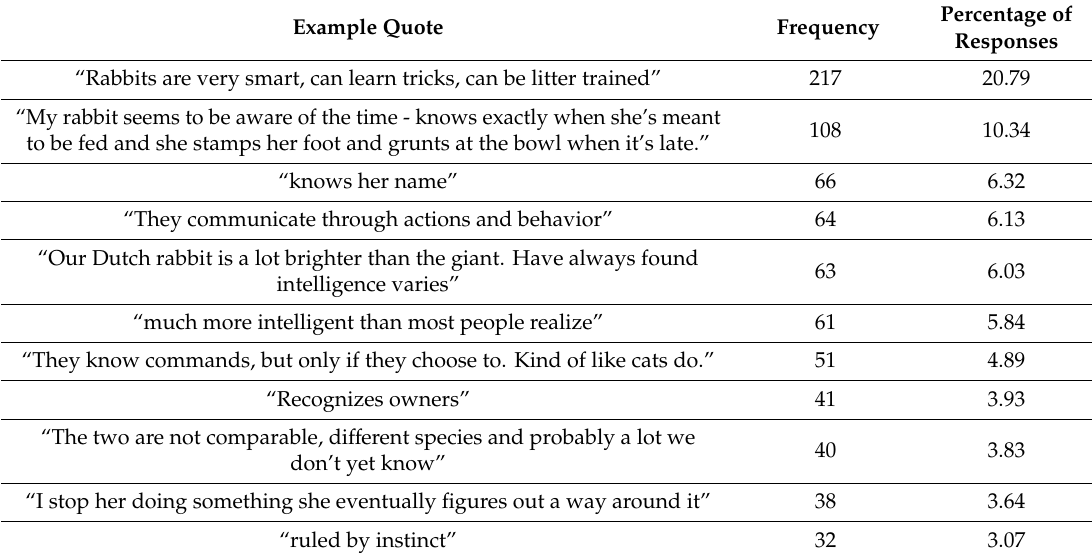
Table 6. Open-ended responses referring to rabbit intelligence. Statements included in the table if they were mentioned in over 3% of responses. n = 670.